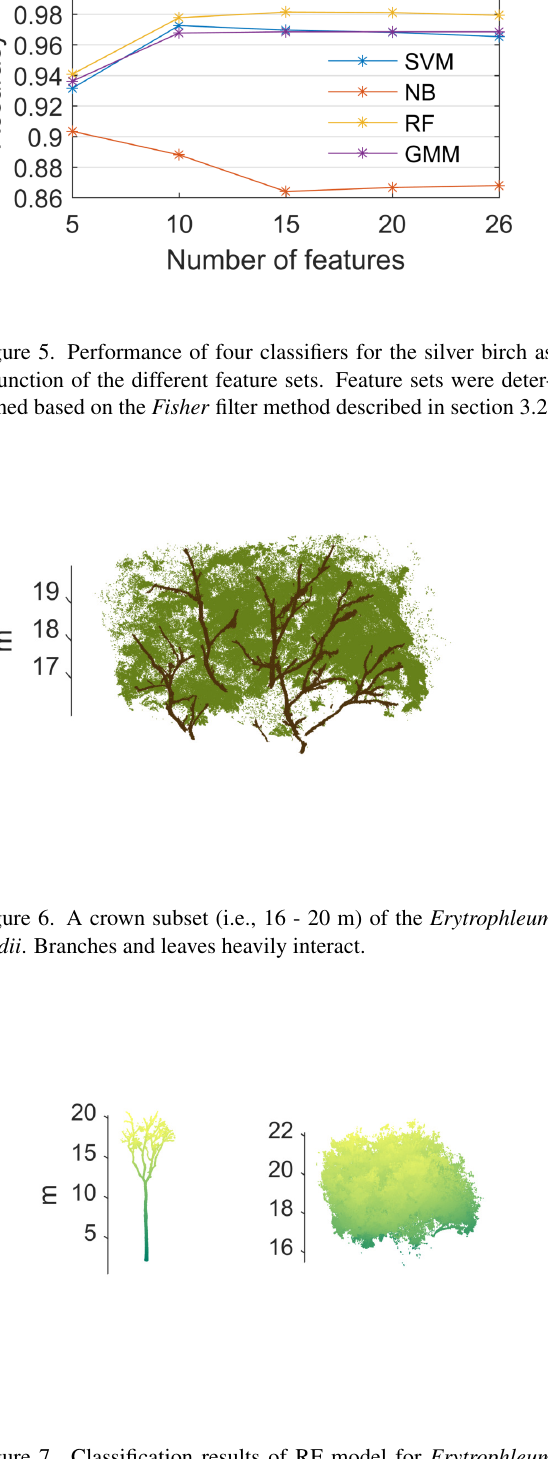
Figure 7. Classification results of RF model for Erytrophleum fordii . Left part shows the wood components and right part shows the leaf